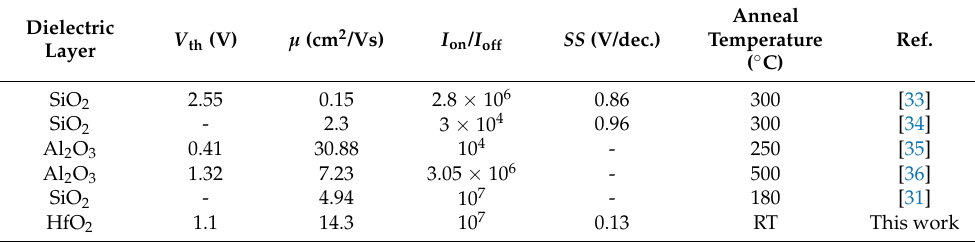
Figure 7. ( a ) Schematic structure of TFT device. ( b ) Transfer curve of TFT. ( c ) PBS (+10 V) and ( d ) NBS ( − 10 V) test for TFTs. Table 1. The electrical performance of IZO TFTs.